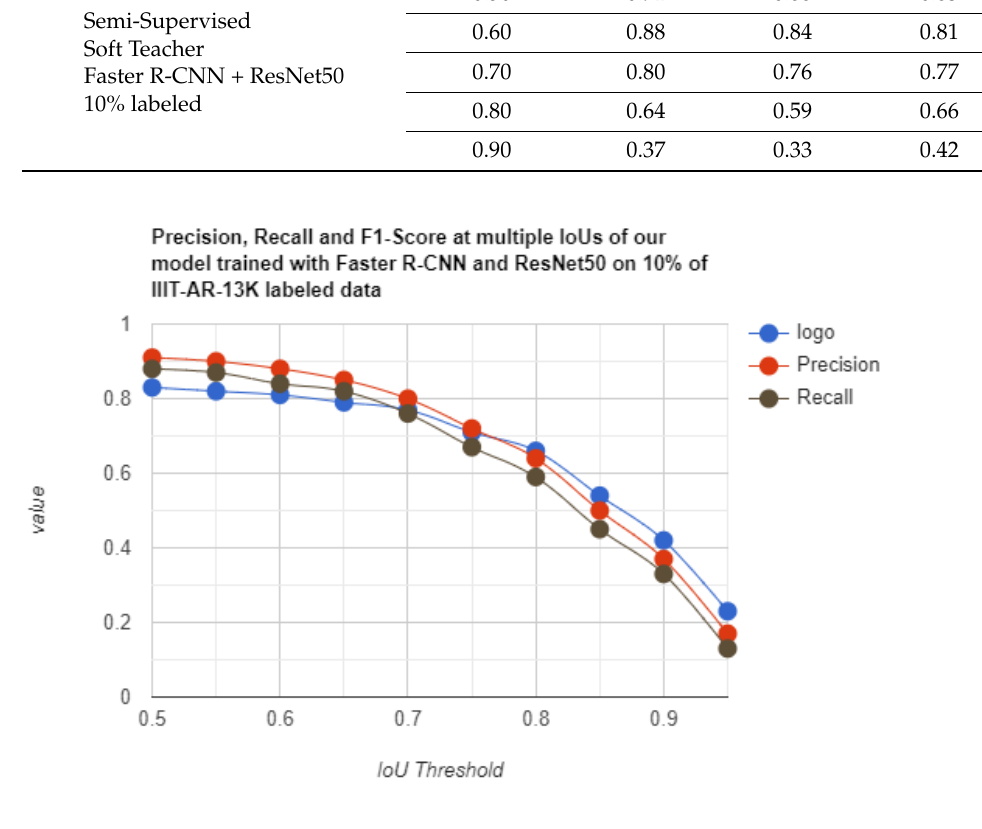
Figure 10. A visual representation of Precision, Recall and F1-Score at multiple IoUs. The model is trained on 10% IIIT-AR-13K labeled data and is equipped with Faster R-CNN and ResNet50.